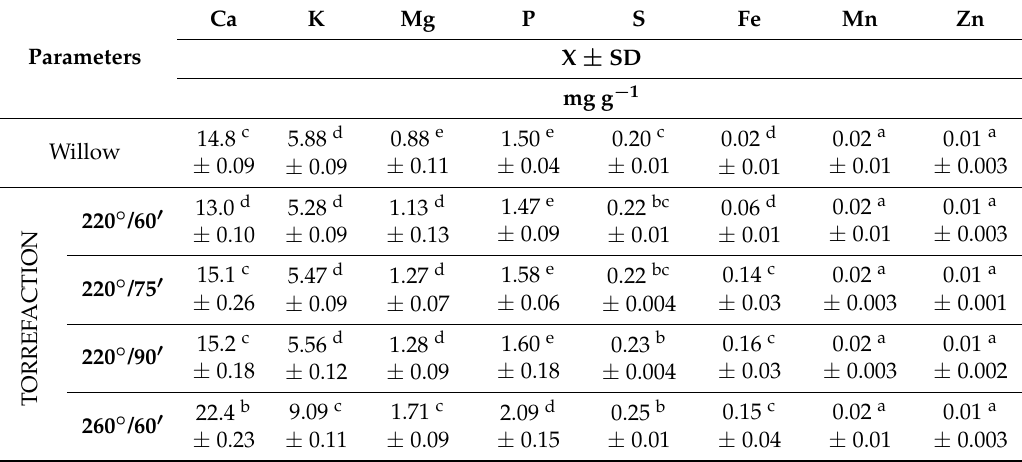
Table 6. The content of Ca, K, Mg, P, S, Fe, Mn, and Zn in willow and torrefied products.